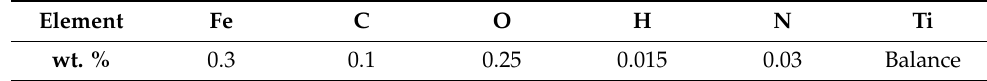
Table 2. Chemical composition of the titanium Grade 2.